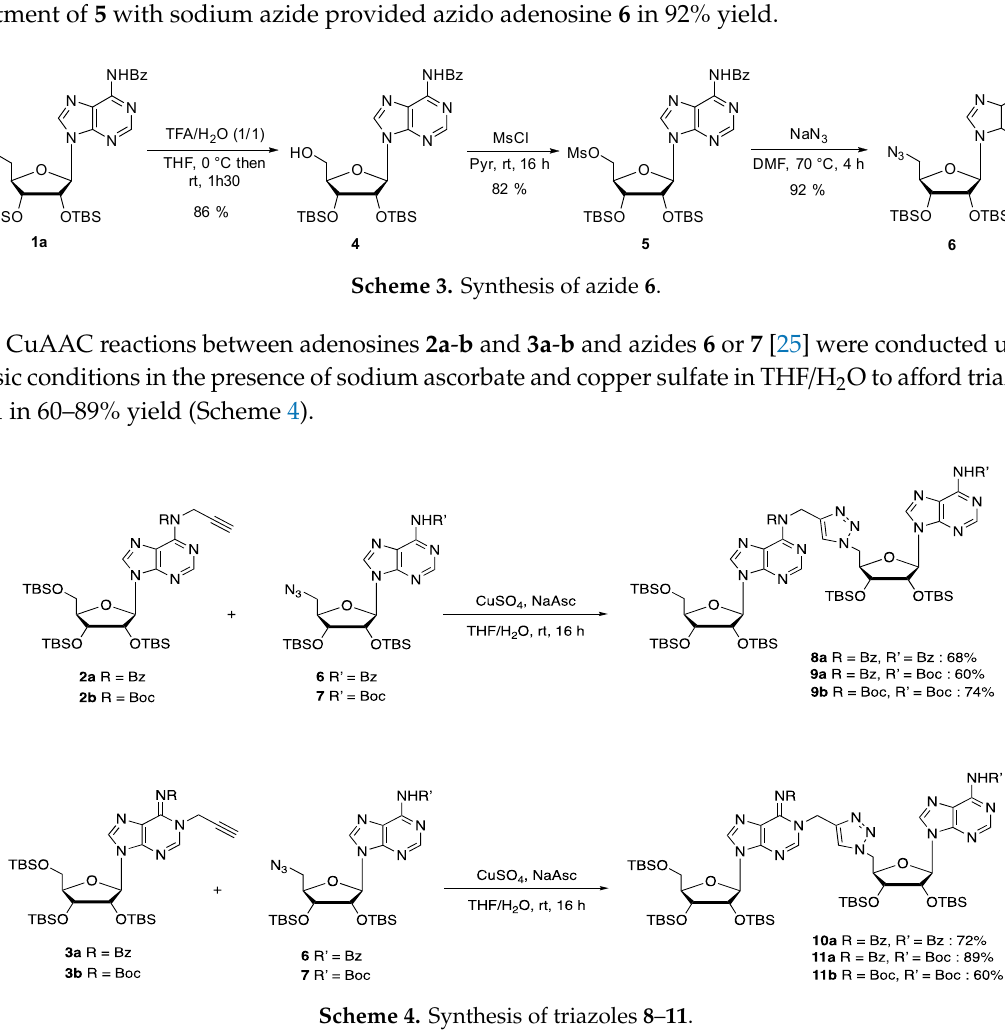
Figure 2. 2D HMBC spectra (500 MHz, CDCl 3 ): ( A ) N 6 -propargyladenosine derivative 2a . ( B ) 1-propargyladenosine derivative 3a